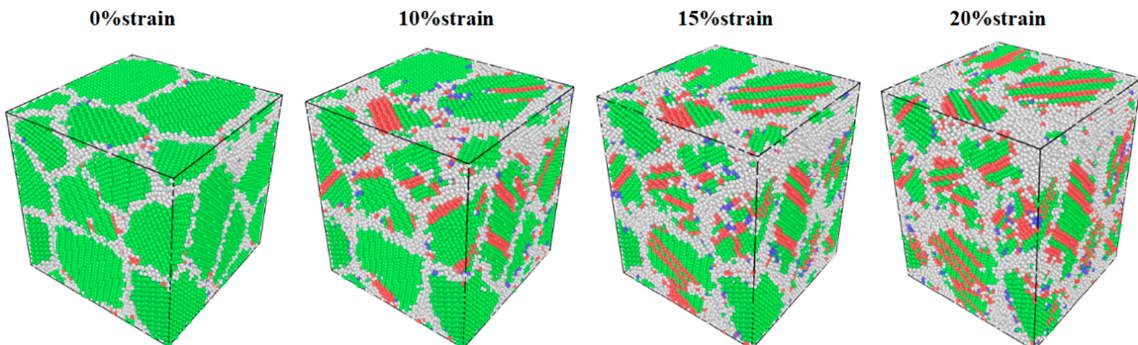
Figure 7. Structural evolution of CoCrNi polycrystals at different strains.